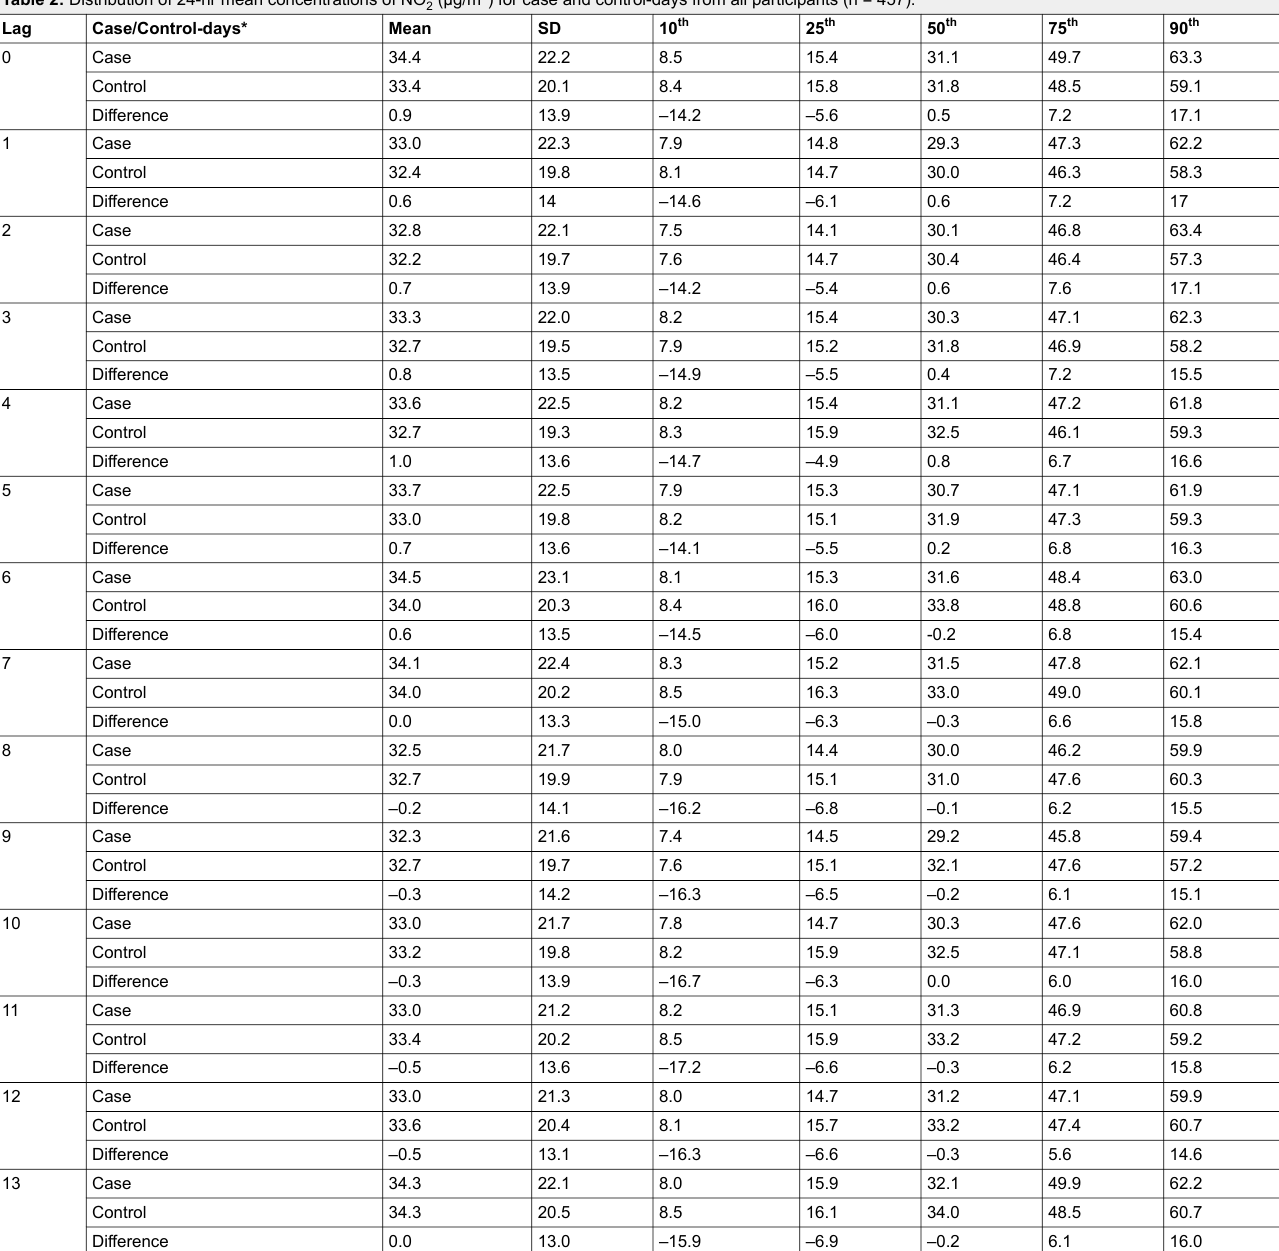
Table 2: Distribution of 24-hr mean concentrations of NO 2 (µg/m 3 ) for case and control-days from all participants (n = 457). Lag Case/Control-days*